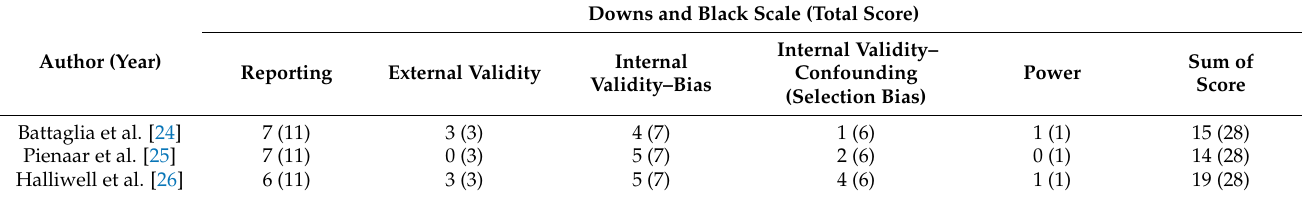
Table 2. Risk of Bias Assessment.